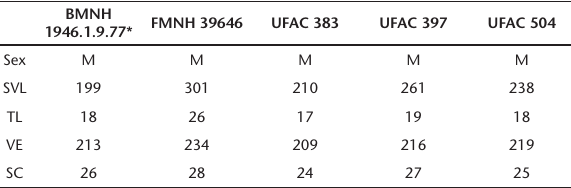
Table 2. Variation in characters of five specimens of Apostolepis ni- groterminata . Snout-vent length (SVL), tail length (TL), ventrals (VE) and subcaudals (SC). The UFAC specimens presumably are males; the FMNH 39646 specimen is a male. *Holotype, data from Lema and Renner (2016: 67). Measurements in mm.